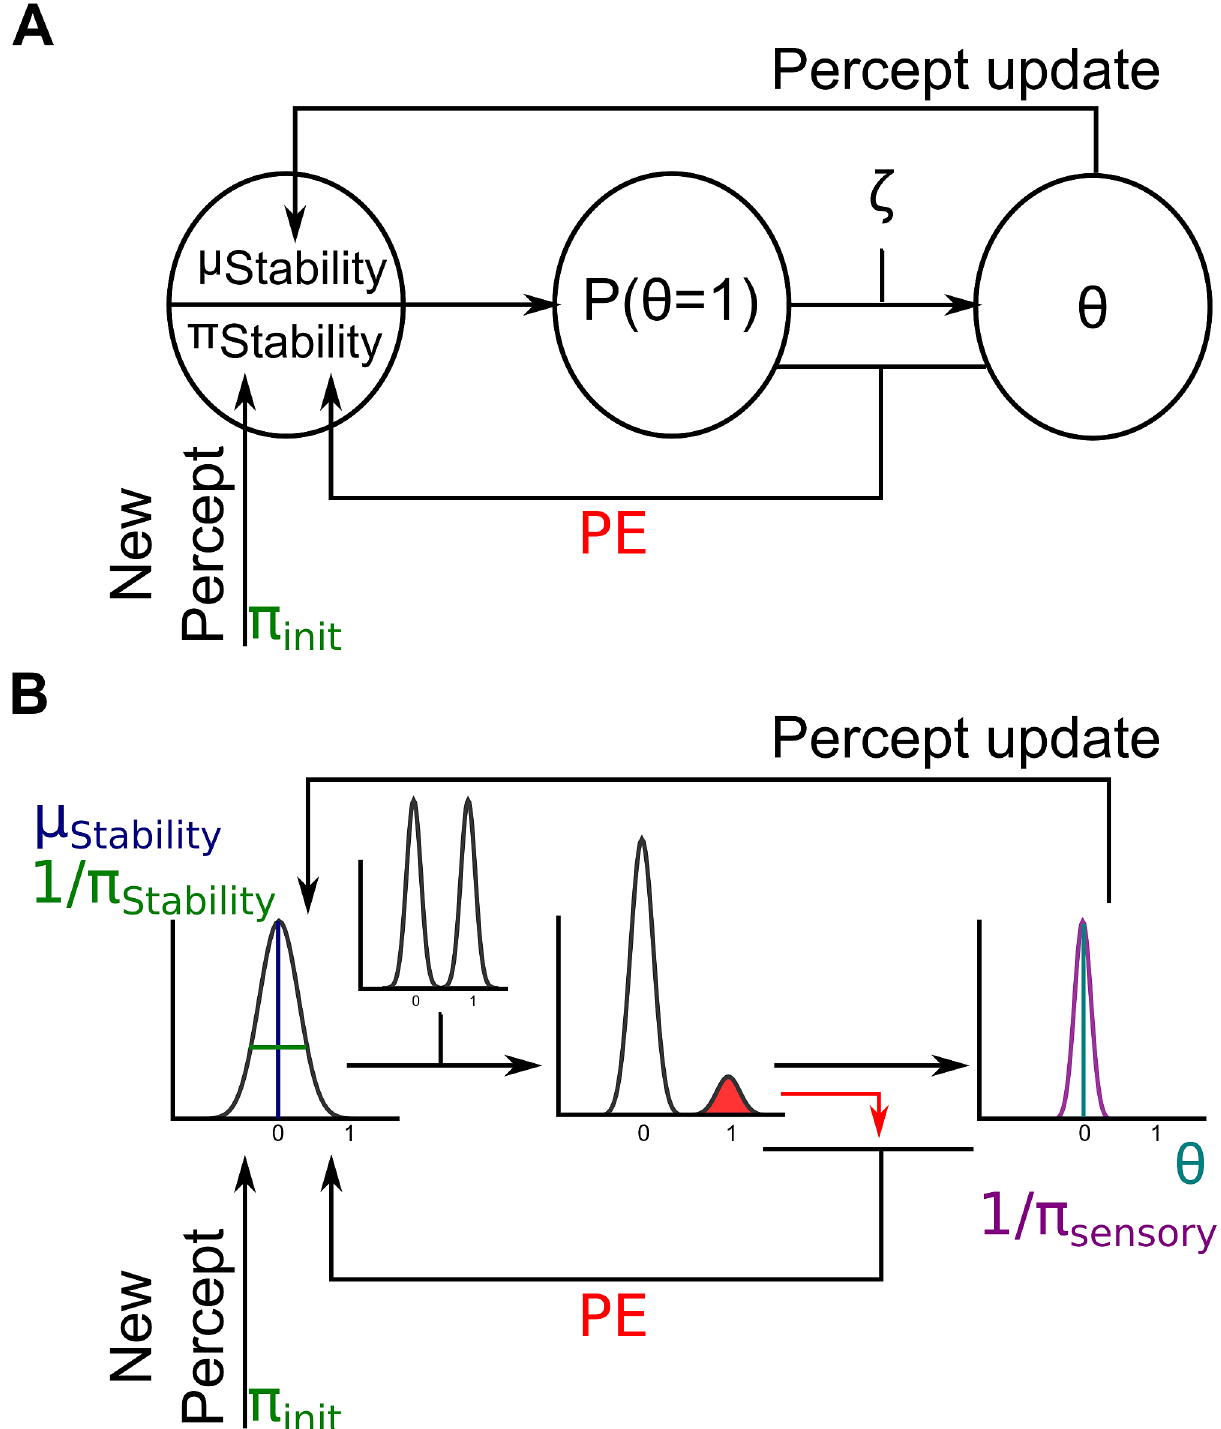
Fig 2. Bayesian modeling procedure. (A) The prior distribution ‘ perceptual stability ’ is defined by its mean μ stability (corresponding to the perceptual decision made at the last self-occluding configuration, see ‘ Percept update ’ -arrow) and its precision π stability . If a new percept was reported at the preceding trial, π stability is set to π init produce a weighted bimodal distribution P ( θ ), which is in a next step transformed by a unit-sigmoid function determined by parameter ζ and used to predict the perceptual outcome θ . The difference between P ( θ = 1) and θ constitutes the prediction error (PE). (B) In this illustration with exemplary Gaussian probability distributions, the prior distribution ‘ perceptual